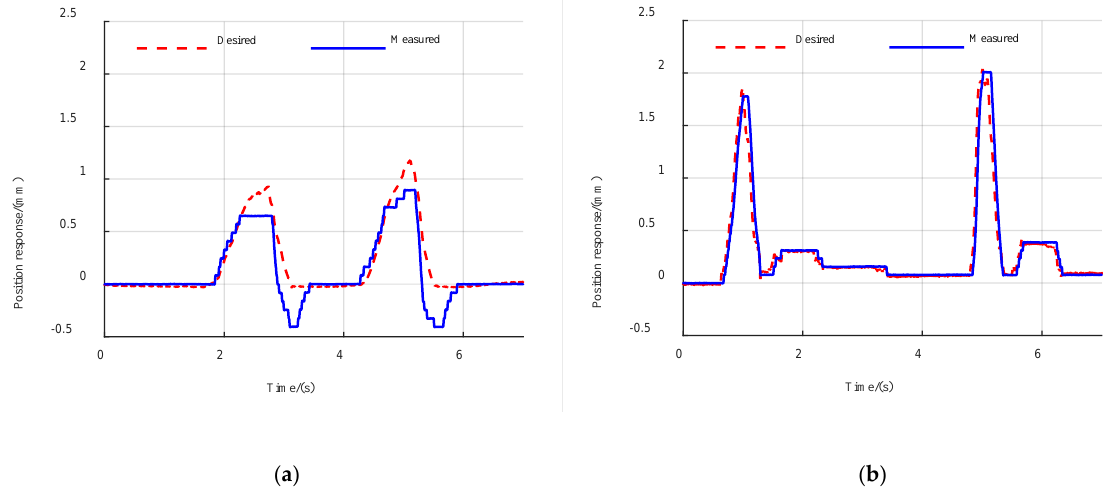
Figure 7. Comparison of desired/measured position response under impact disturbances. ( a ) PID-based position controller; ( b ) proposed controller.